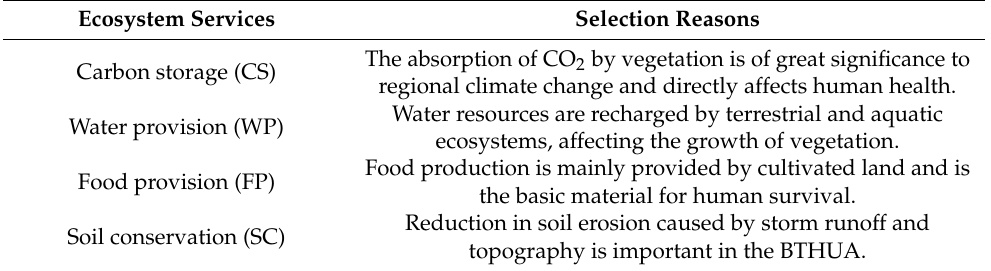
Table 2. Ecosystem services evaluated in the Beijing–Tianjin–Hebei urban agglomeration. Ecosystem Services Selection Reasons The absorption of CO 2 by vegetation is of great significance to Carbon storage (CS) regional climate change and directly affects human